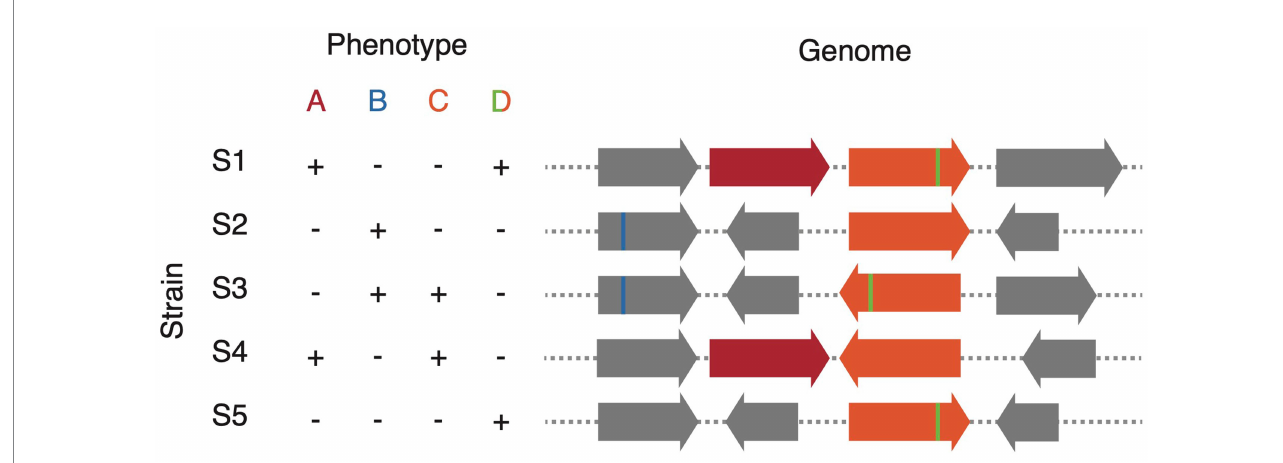
FIGURE 2 Schematic representation of comparative genomics analysis to match genotype to phenotype. Phenotype A results from the variable presence of a gene (red), phenotype B from a SNP (blue), phenotype C from a structural variant (orange), and phenotype D from a combination of variants: the simultaneous presence of structural variation (orange) and a SNP